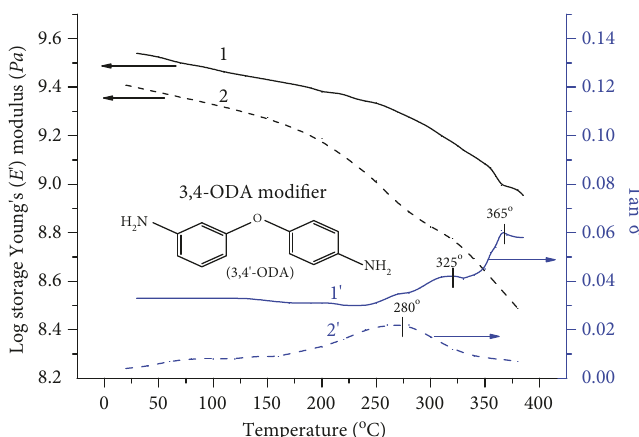
Figure 11: Temperature dependencies of storage Young ’ s modulus E ′ and tan δ of the ROL-I-3,4 ′ -ODA blend (1) and the cured neat ROL-I (2). The DMA experiments were carried out in a tension mode at 660 Hz.